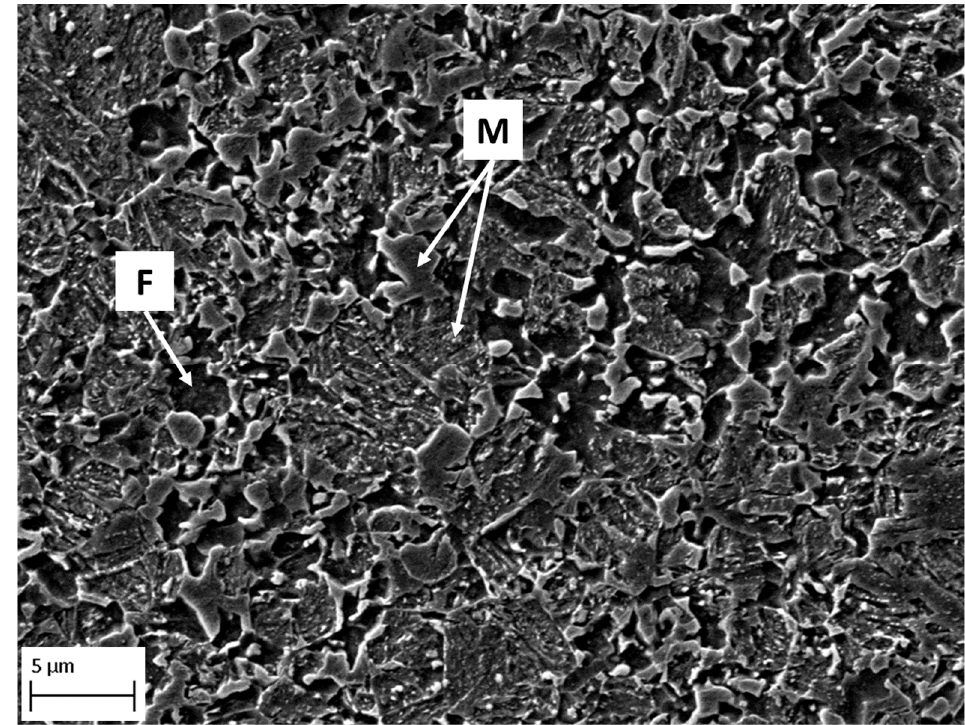
Figure 1. Microstructure of DP1000 from SEM after etching; F—ferrite, M—martensite. HERS was used for in situ monitoring of the added diffusible hydrogen content. The